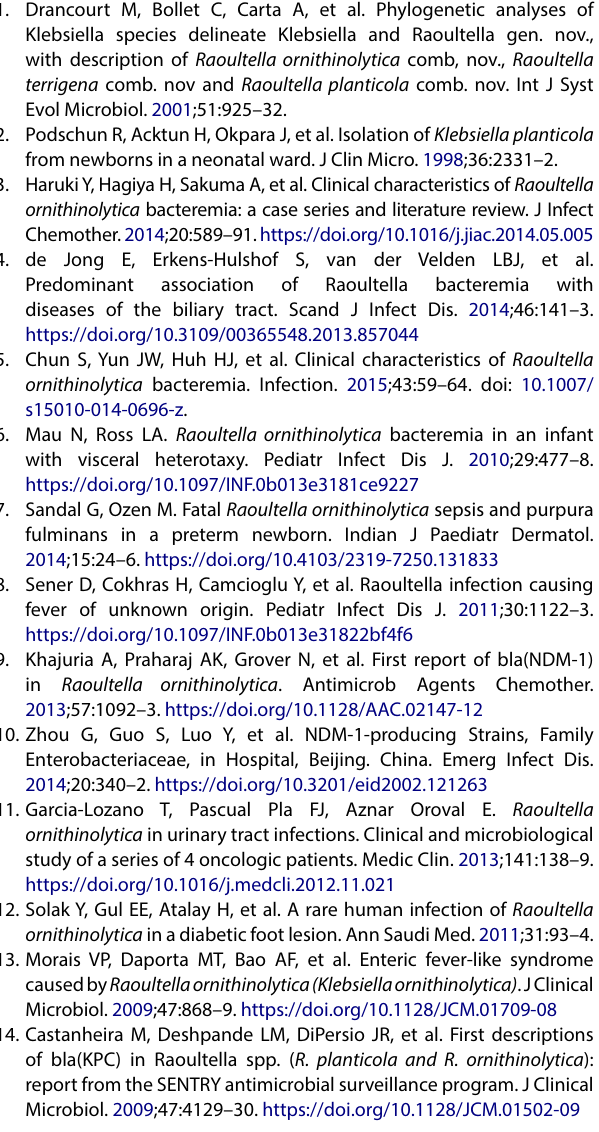
Table 1: Antibiogram of Raoultella